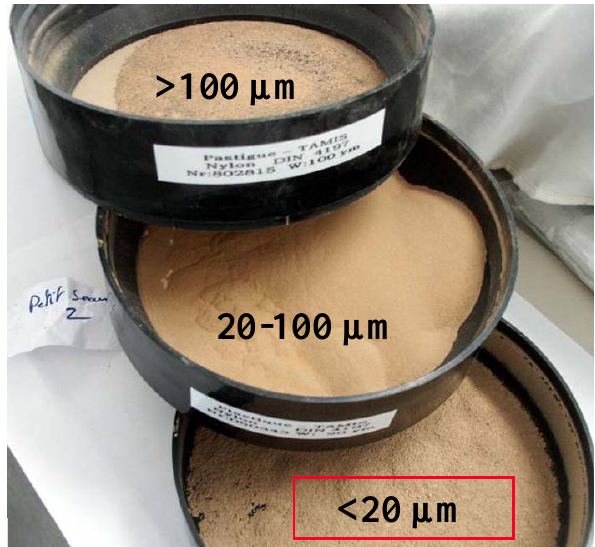
Fig. 5. Soil collected on the three stages of the dry sieving column at the end of the fine particle production process. The relative colors are indicative of the respective content: the upper stage (100-µm mesh) retains small organic debris (black grains), the largest sand grains and possibly clay aggregates; the intermediate stage (20-µm mesh) which contains about 3/4 of the total mass contains mostly the fine, orange-yellowish colored, sand mode and a fraction of ag- gregated clay; the bottom stage contains the light brown-yellowish, finest fraction of disaggregated particles, dominated by clay (photo F.